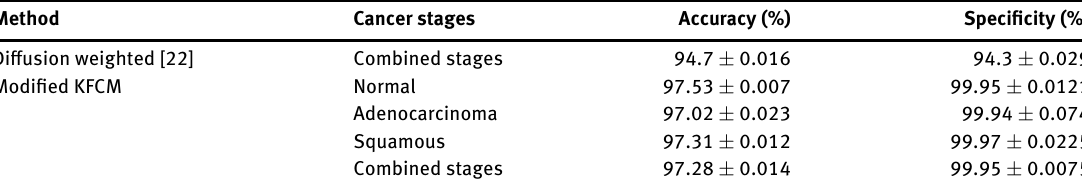
Table 3: Performance comparison of the proposed and existing approach by means of accuracy and specificity.